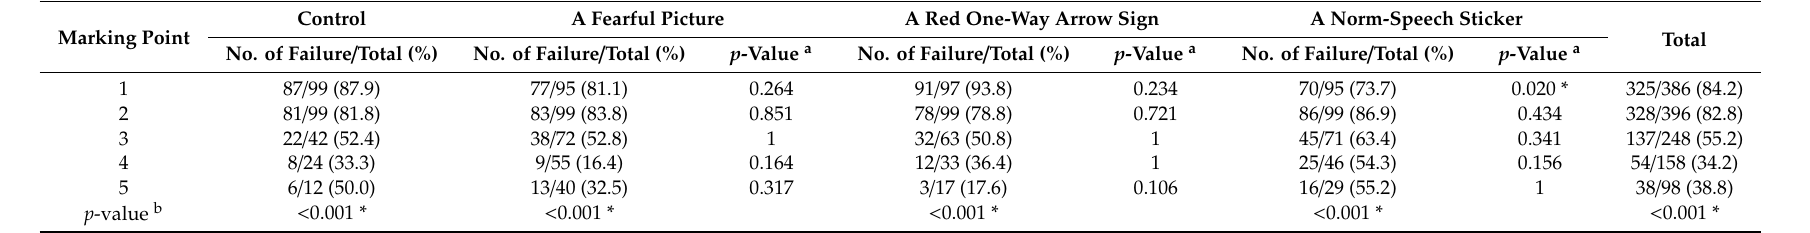
Table 2. Number of recorded failures of physical distancing at each marking point, compared with the control group. Marking